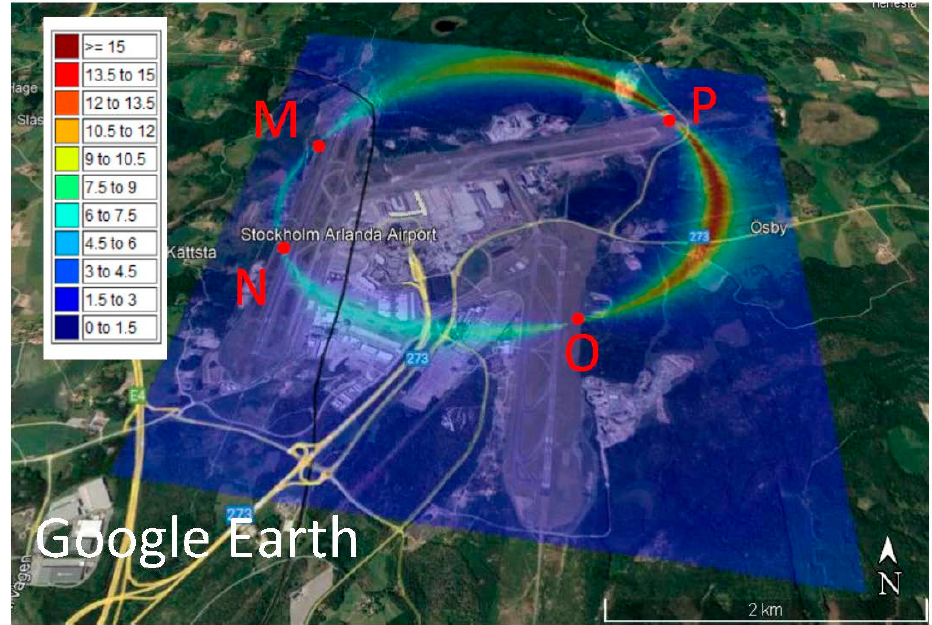
Figure 2. Dilution of precision (DOP) of the initial design of a security localisation network based on the received signal strength differences (RSSD) over the Google Earth map of the Arlanda international airport.